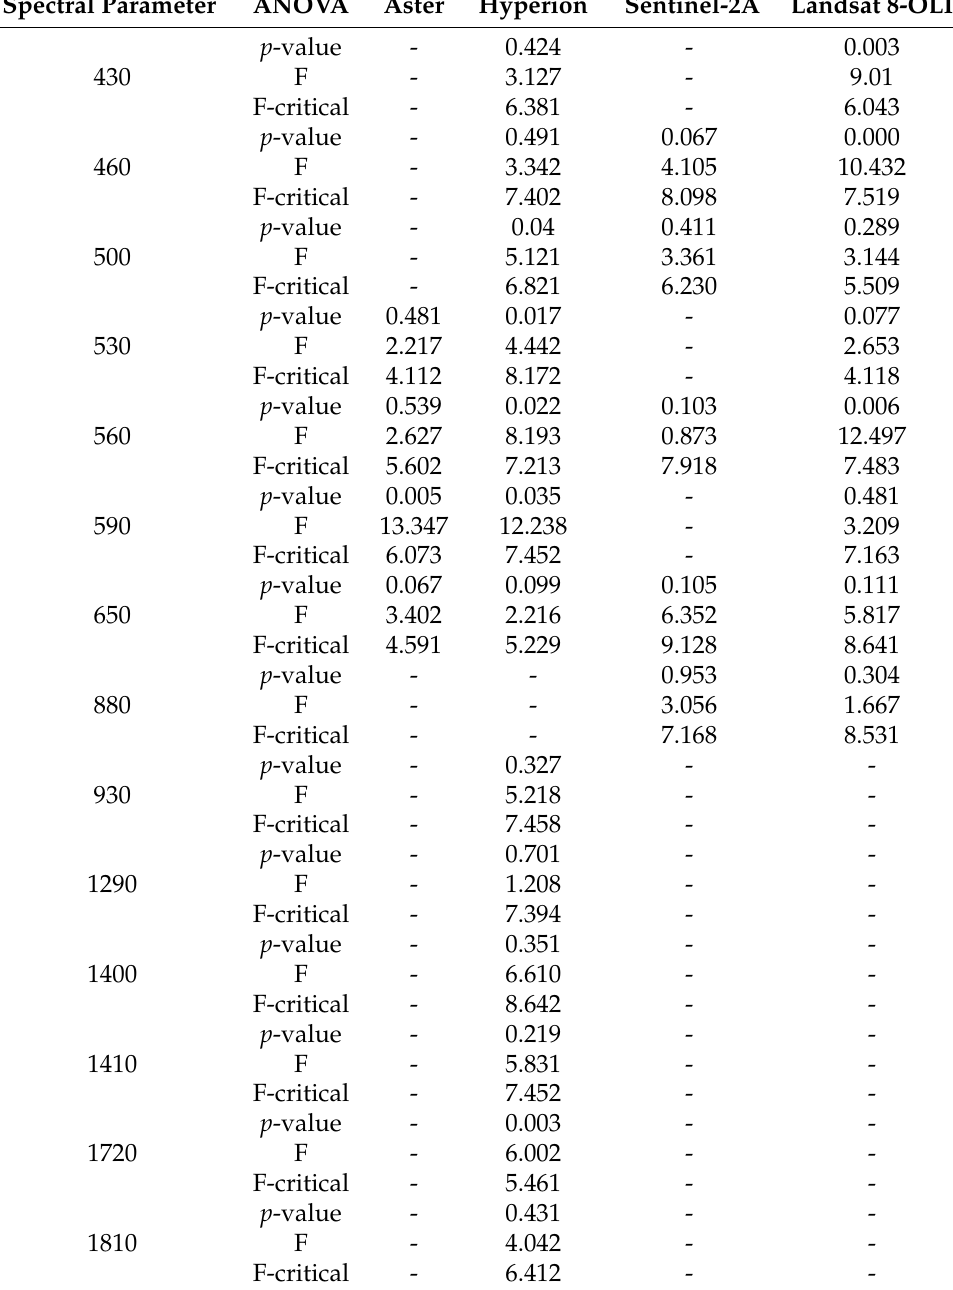
Table A1. One-way ANOVA test results between selected bands of samples’ and image pixels’